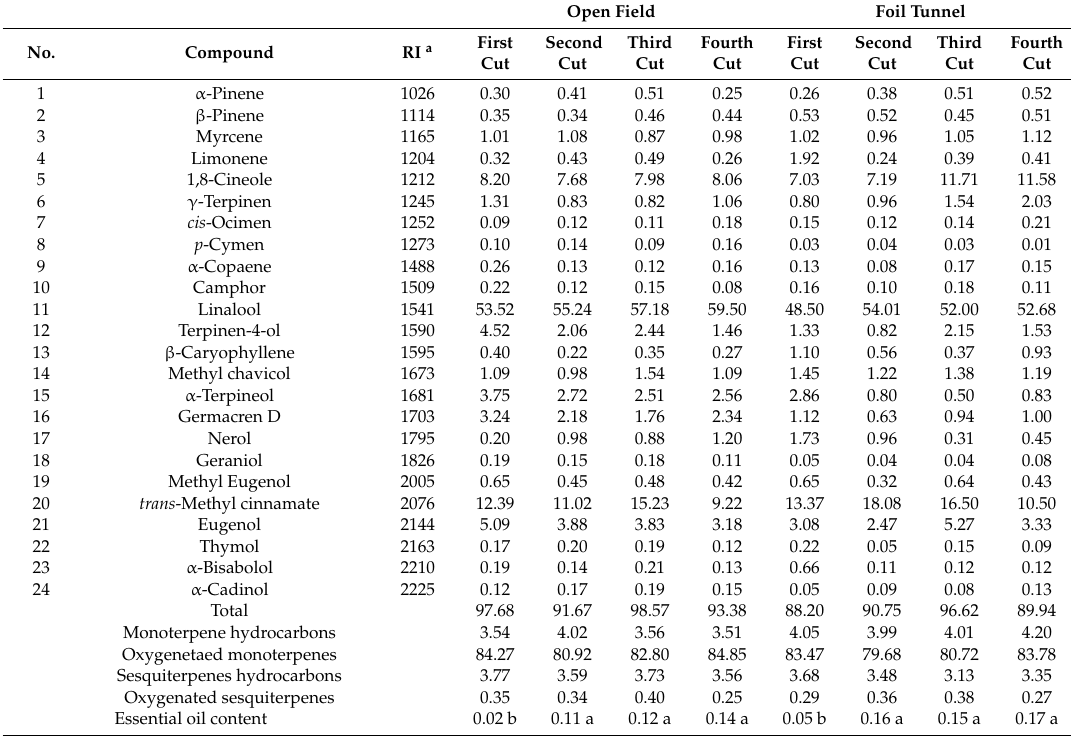
Table 4. The total content (g · 100 g − 1 ) and gas chromatography composition (percentage peak areas) of essential oils in the fresh herbs.